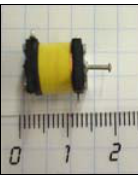
Figure 2. Miniature push solenoid with the stroke released (scale in